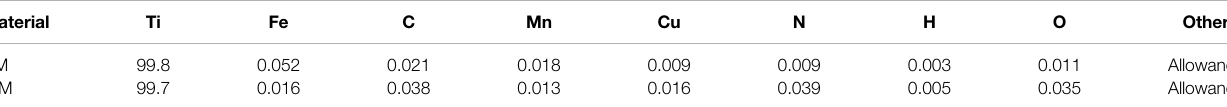
TABLE 1 | Percentage of atoms in different areas of welded joints.